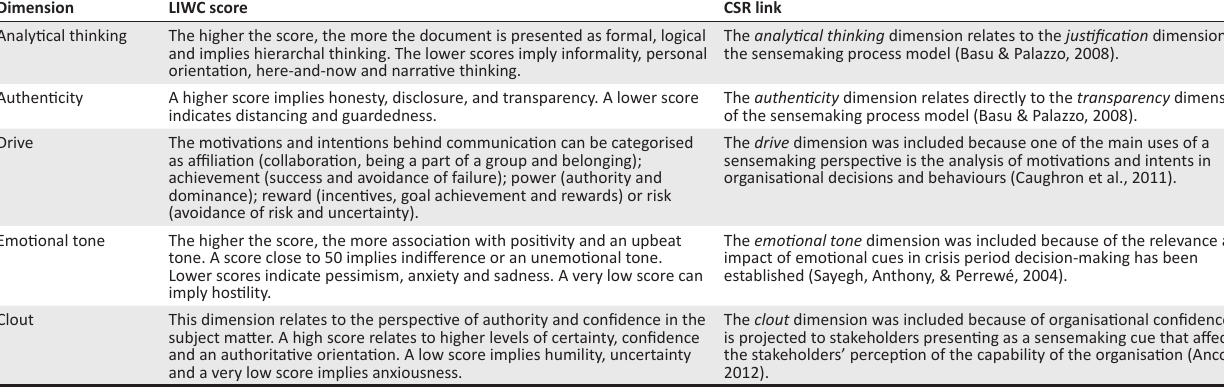
TABLE 1: Corporate social responsibility and linguistic sensemaking dimensions.